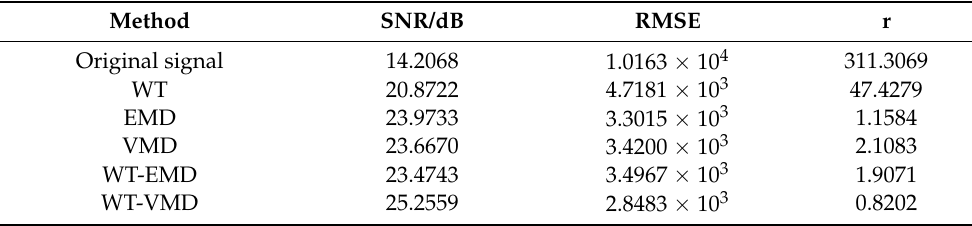
Figure 4. Experimental results of denoising of 1000-pulse cumulative simulation signals (no pollution): ( a ) original signal; ( b ) WT; ( c ) EMD; ( d ) VMD; ( e ) WT-EMD; ( f ) WT-VMD. Table 2. Evaluation index of 100-pulse cumulative signal (no pollution) after denoising.